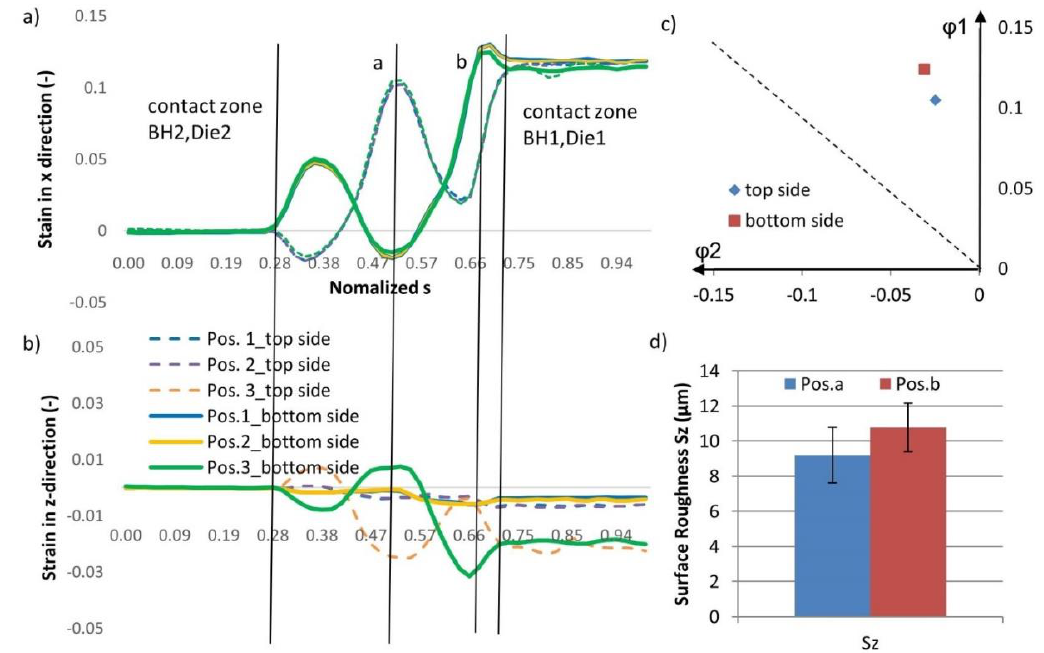
Figure 23. ( a ) Numerical calculated strain in x-direction regarding normalized s; ( b ) numerical calculated strain in z-direction regarding normalized s; ( c ) maximal strain states on top and bottom side (top side: Pos.a; bottom side: Pos.b; ( d ) surface roughness Sz at Pos.a and b according to 3d surface scanning through µSurf.